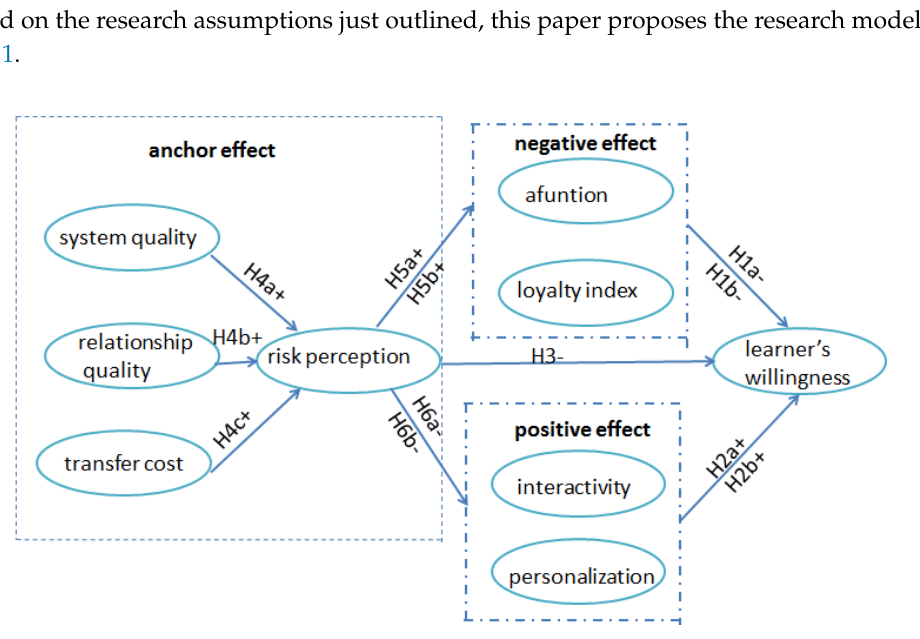
Figure 1. Research